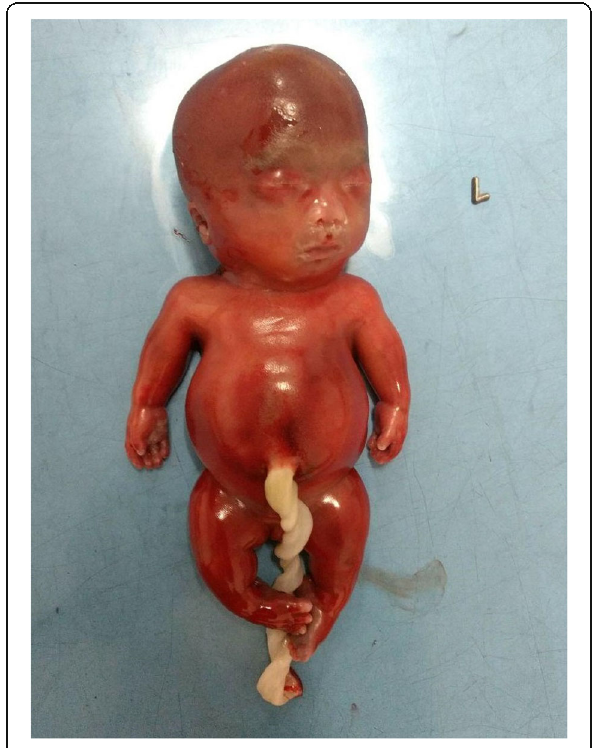
Fig. 2 Midsagittal ultrasound image of the fetus shows the near- complete absence of vertebral body ossification centers in the entire extent of the spine (arrows)